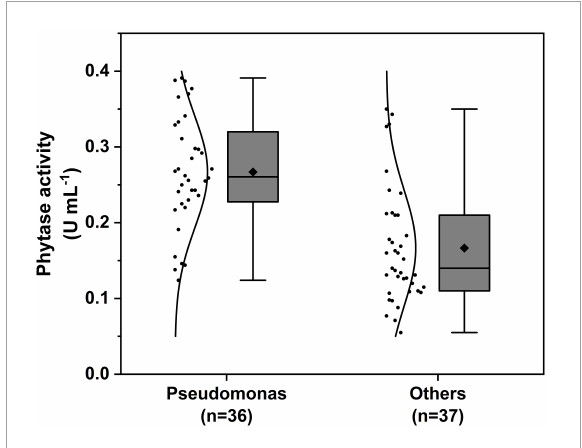
FIGURE2 Comparison analysis of phytase activity between genera of Pseudomonas and